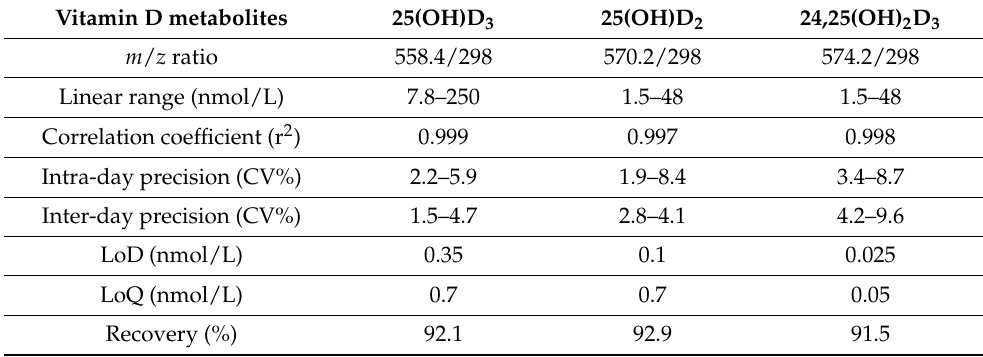
Table 1. Analytical performance of the vitamin D metabolites in CSF with LC-MS/MS method. Vitamin D